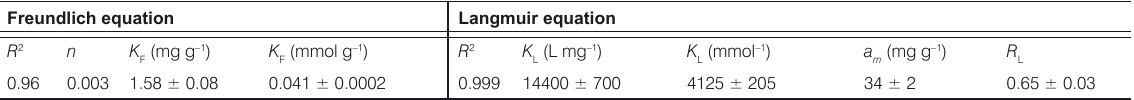
Table 4. The characteristics of mercury(II) adsorption at 22 °C calculated by the Freundlich and Langmuir equations for β -cyclodextrin-containing